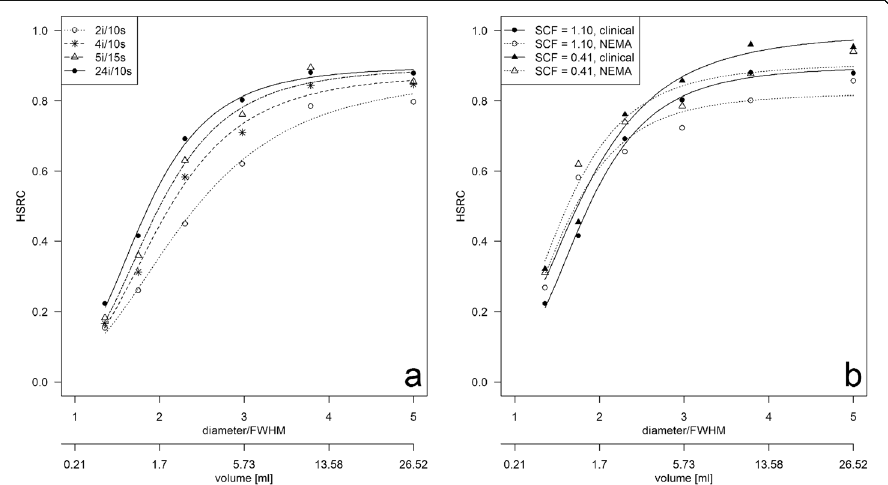
Fig. 1 Effect of the reconstruction setup on the hot spot recovery coefficients (HSRC) of the examined spheres. a HSRCs of the clinical acquisition protocol (60 projections, 20 s/projection) for different reconstruction setups (SCF 1.10 in combination with four different iteration sets). b HSRCs for a fixed set of iterations (24i/10s) demonstrating effects by the acquisition protocol (clinical or NEMA) and SCF (SCF = 1.10 or 0.41). HSRC was plotted against sphere diameter normalized to FWHM at 100 mm with LEHR collimator (FWHM = 7.4 mm) and sphere